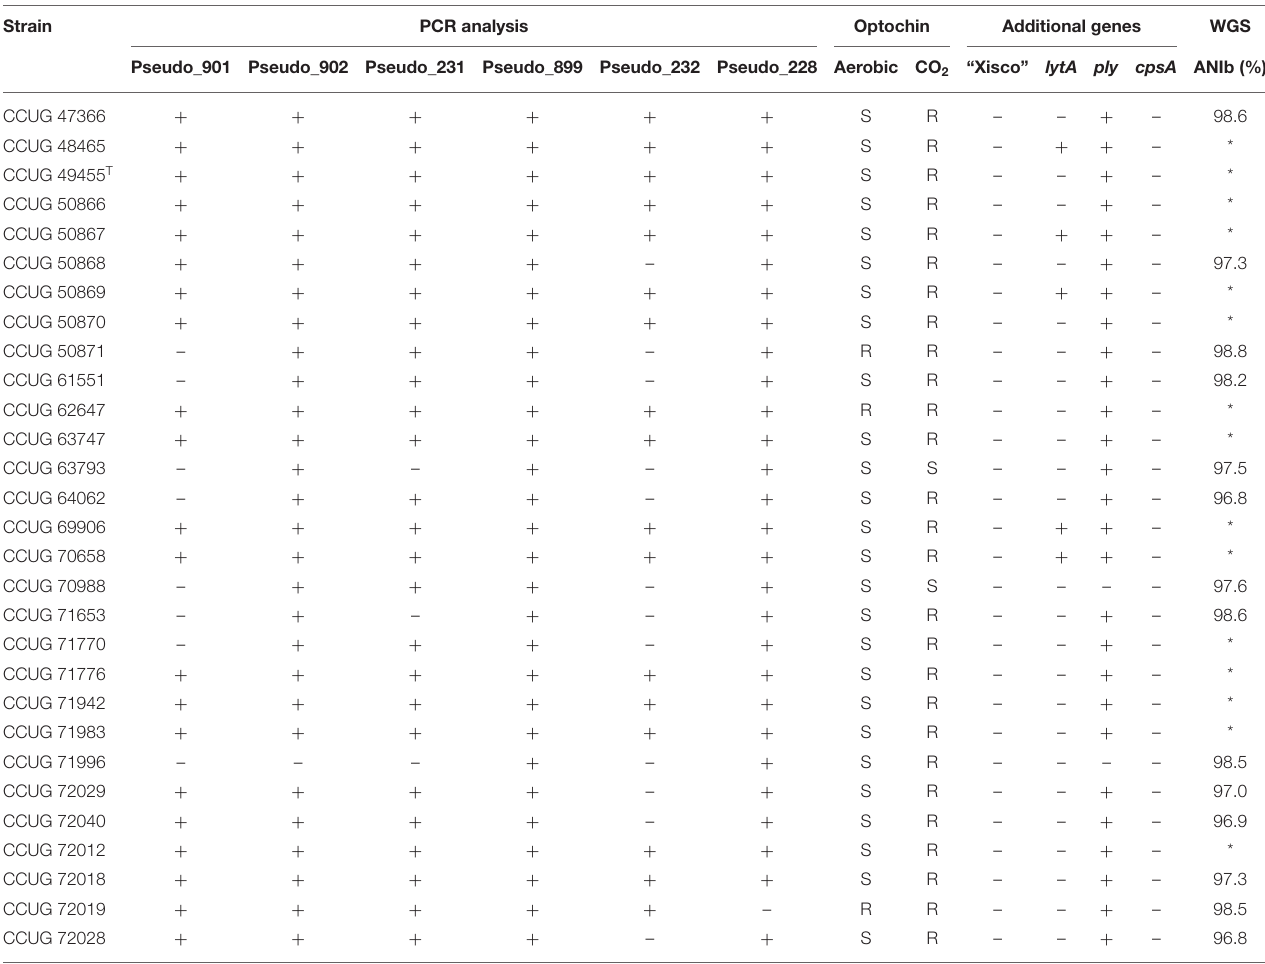
TABLE 5 | Genotypic and phenotypic characterization of the 29 S. pseudopneumoniae strains used for confirmation of gene markers; ANIb similarity values calculated with JSpeciesWS against S. pseudopneumoniae type strain CCUG 49455 T are indicated if the whole genome sequence was determined.